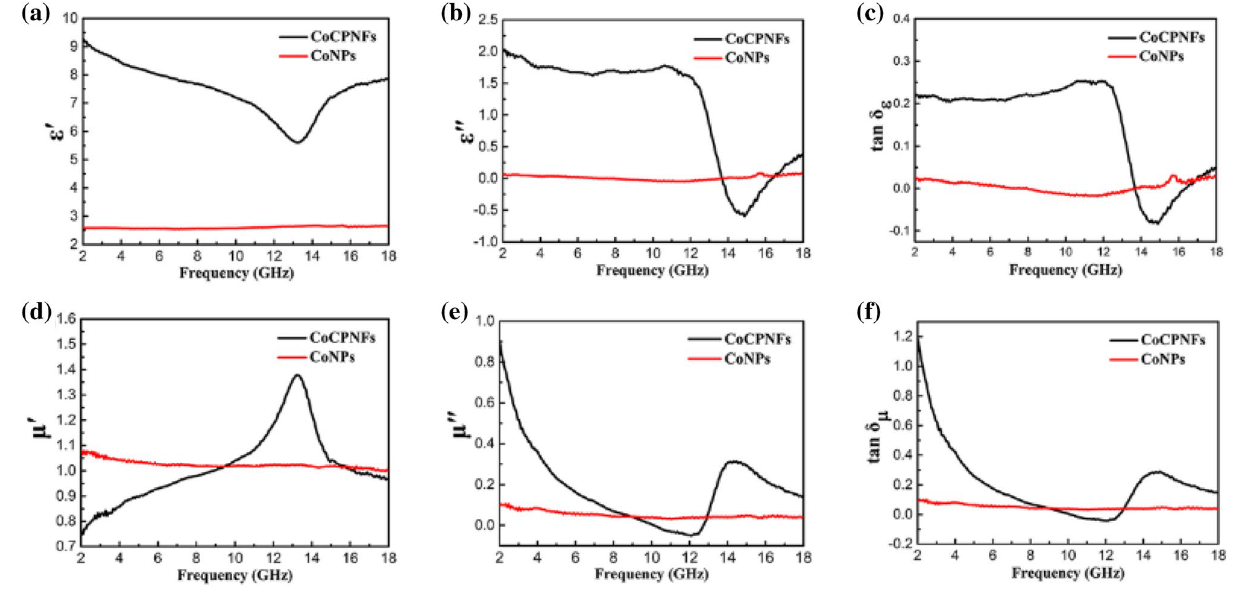
Figure 7. Frequency dependence of ( a ) real parts (ε ′ ) and ( b ) imaginary parts (ε ″ ) of complex permittivity; ( d ) real parts (µ ′ ) and ( e ) imaginary parts (µ ″ ) of complex permeability; ( c ) dielectric loss (tanδ ε ) and ( f ) magnetic loss (tanδ µ ) for CoNPs and